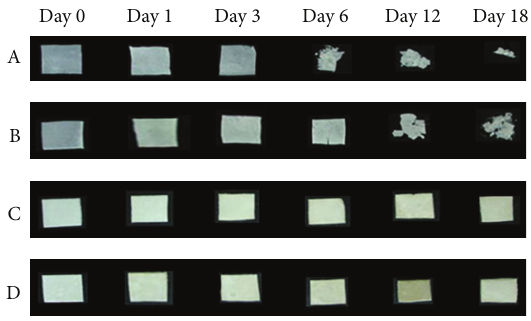
Figure 3: Images of the four groups of porous silk scaffolds after degradation by collagenase IA(1.0 UmL −1 ,pH 7.4, 37 ∘ C)for different numbers of